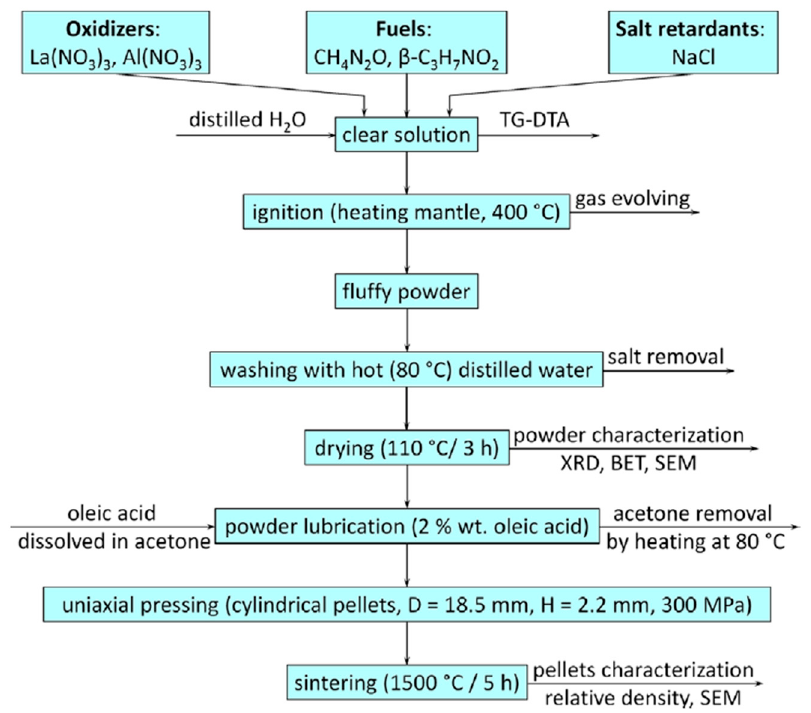
Figure 21. Flowchart showing LaAlO 3 perovskite preparation, sintering, and characterization (Reprinted with permission from [77]).